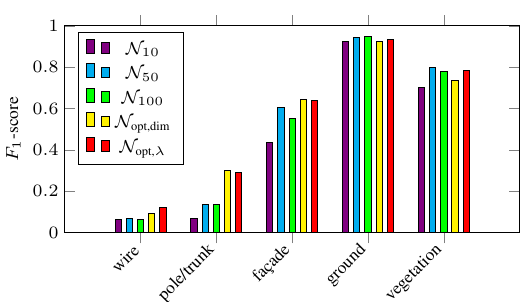
Figure 3: F 1 -scores for QDA-based classification.